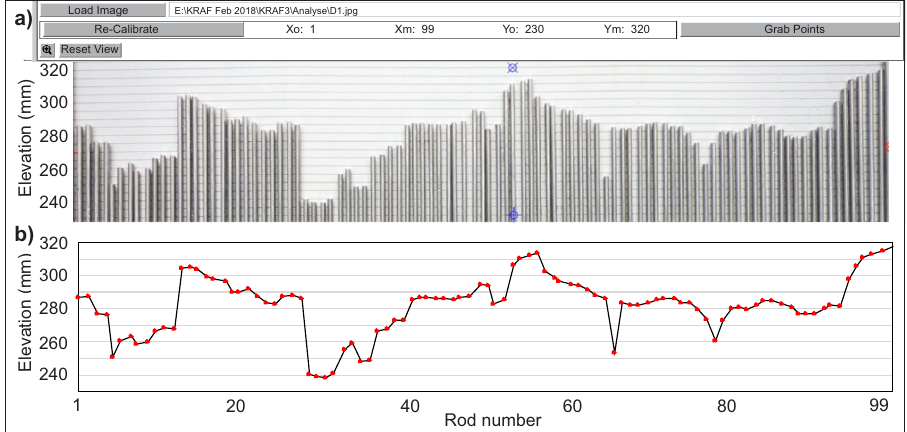
Fig. 6 Overview of steps in capturing the digital data from the CRAF. a Images are recti fi ed and placed in a X-Y scale using the Matlab application grabit.m . b Each rod is digitized to create X-Y points and reconstruct the topography of the reef surface.